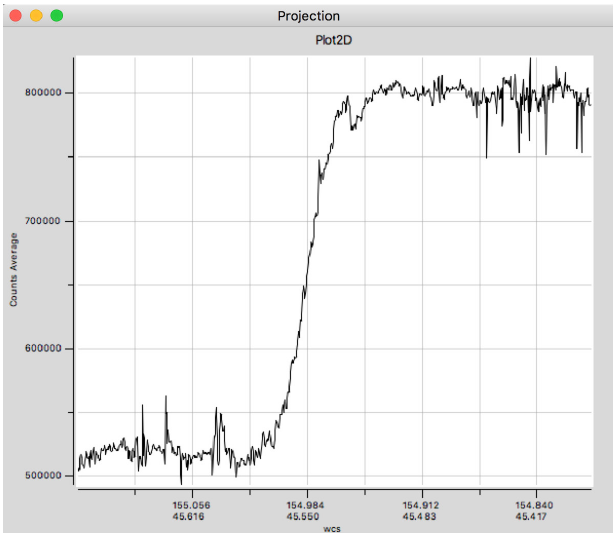
Fig. 49.— Radial velocity profile of NGC 3198 based on the first moment